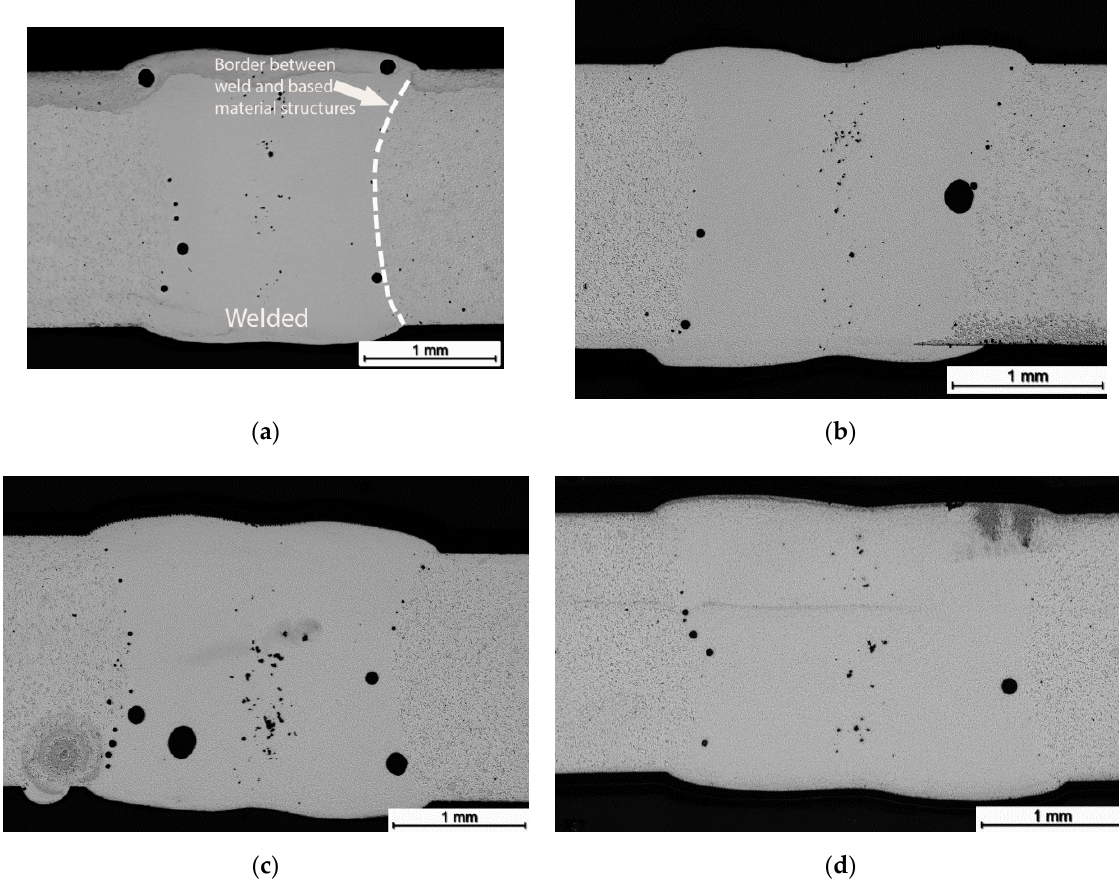
Figure 2. Macrostructure of cross section Ti-15%Mo/TiB composite after LBW at different preheating temperatures: ( a ) without pre-heating; ( b ) 200 °C; ( c ) 400 °C; or ( d ) 600 °C.